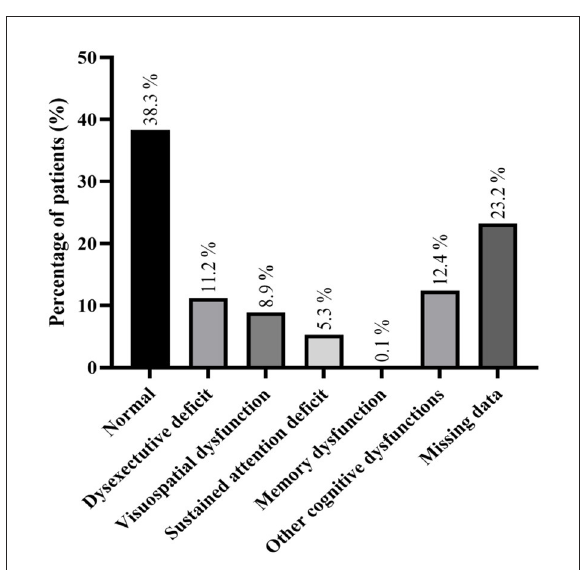
FIGURE3 Detailed neuropsychological examination; more than one neuropsychological dysfunction could be found in some patient.